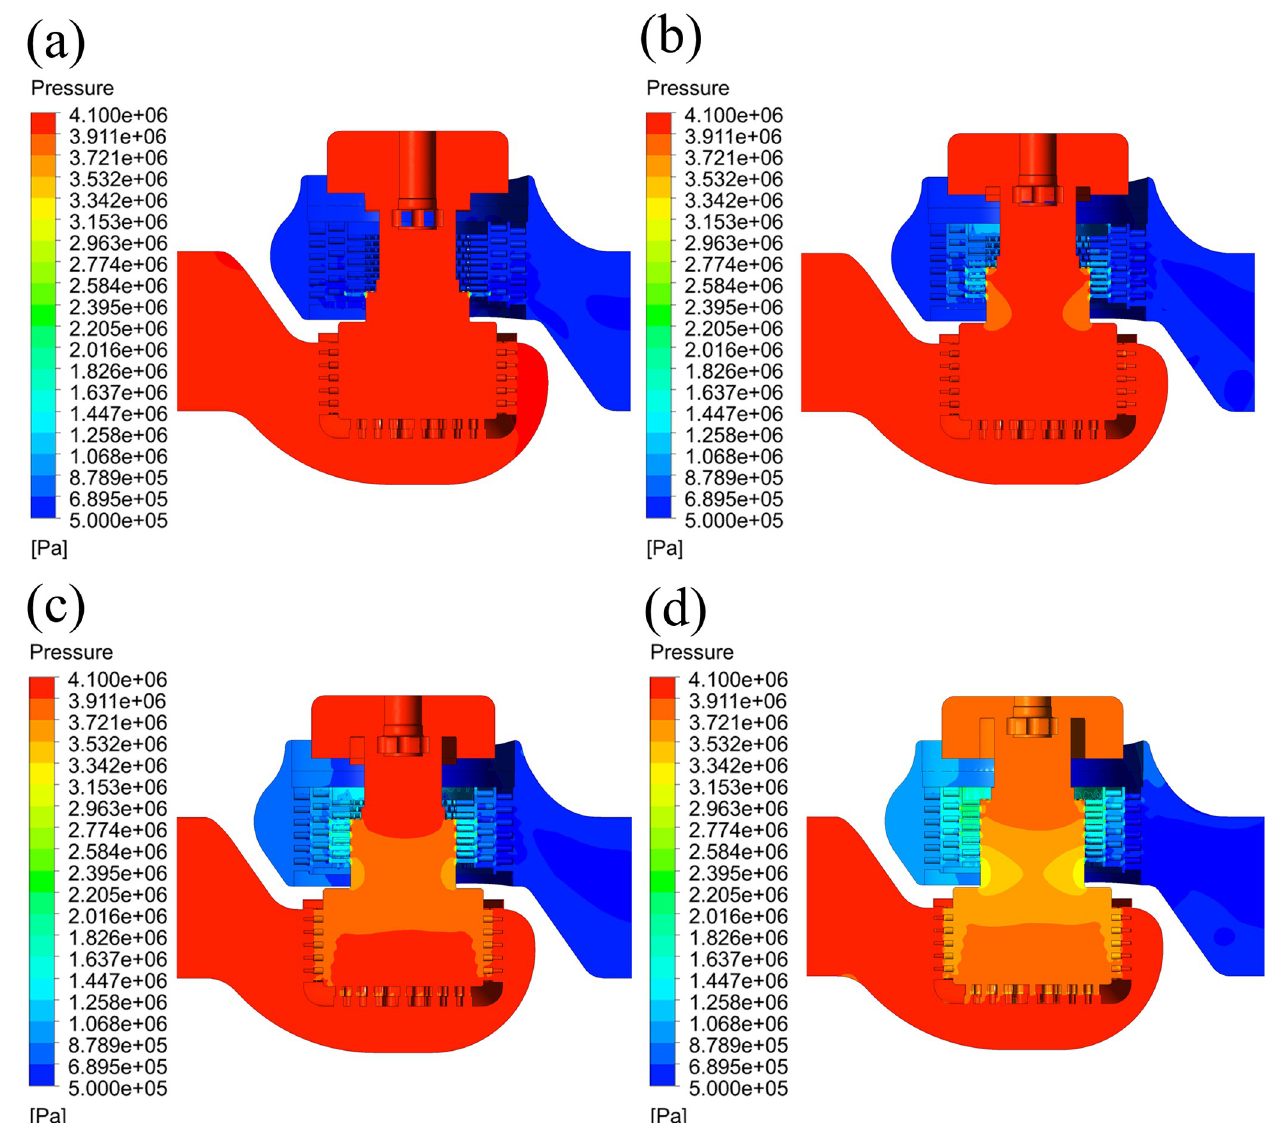
Fig 4. Pressure distribution of the flow field at different opening. (a) 10% opening. (b) 50% opening. (c) 70% opening. (d) 100%